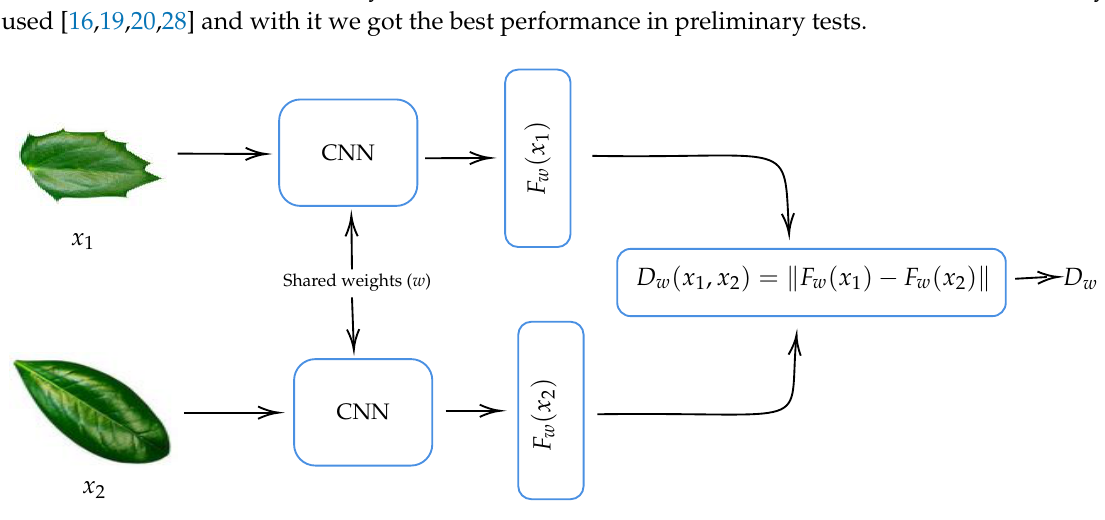
Figure 4. Two copies of this subnetwork are joined by a loss function at the top, which computes a similarity metric that calculates the Euclidean distance between the feature vectors extracted by each subnetwork.